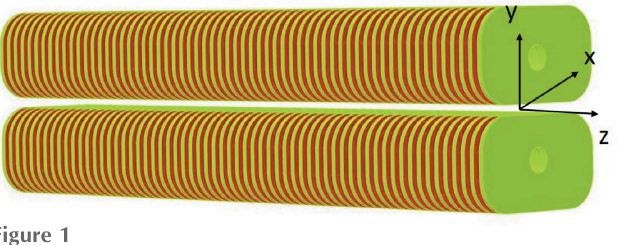
Figure 1 Simulation model with the OPERA-3D program.